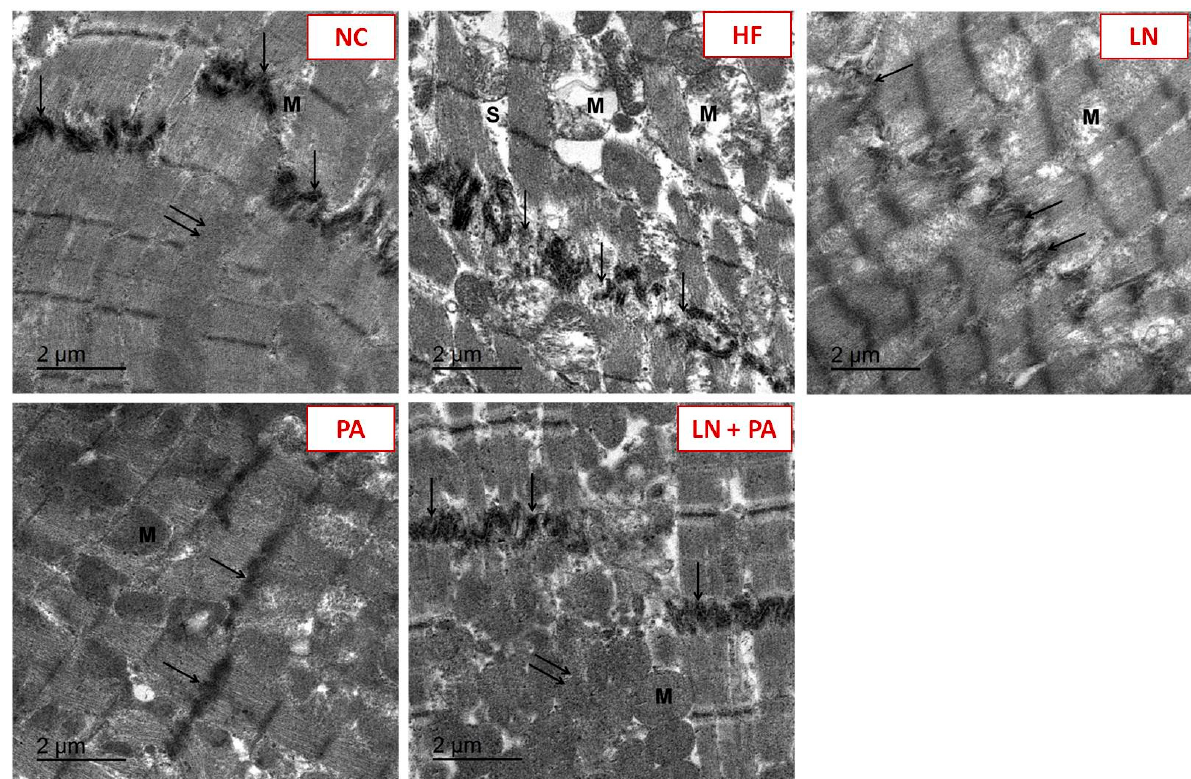
Figure 4. TEM images of intercalated discs in-between cardiac myofibrils in different experimental groups. HF was induced with doxorubicin (3.5 mg/kg, i.p., twice weekly for 3 weeks) and rats were treated with PA (10 mg/kg), LN (10 mg/kg) and their combination (PA + LN) orally and daily for 4 weeks. NC rats showed well-ordered intercalated discs and glycogen particles in-between cardiac myofibrils. HF rats showed disordered intercalated discs between myofibrils. Some mitochondria are swollen with disturbed cristae and membrane. Increased spaces between cardiac myofibrils are also seen. Both LN- and PA-treated groups showed partially organized intercalated discs with swollen mitochondria. LN + PA-treated rats showed near to normal intercalated disc and glycogen particles between myofibrils. Abbreviations: intercalated discs, arrow; glycogen particles, double arrows; mitochondria, M; spaces, S. Scale bar: 2 μ m.